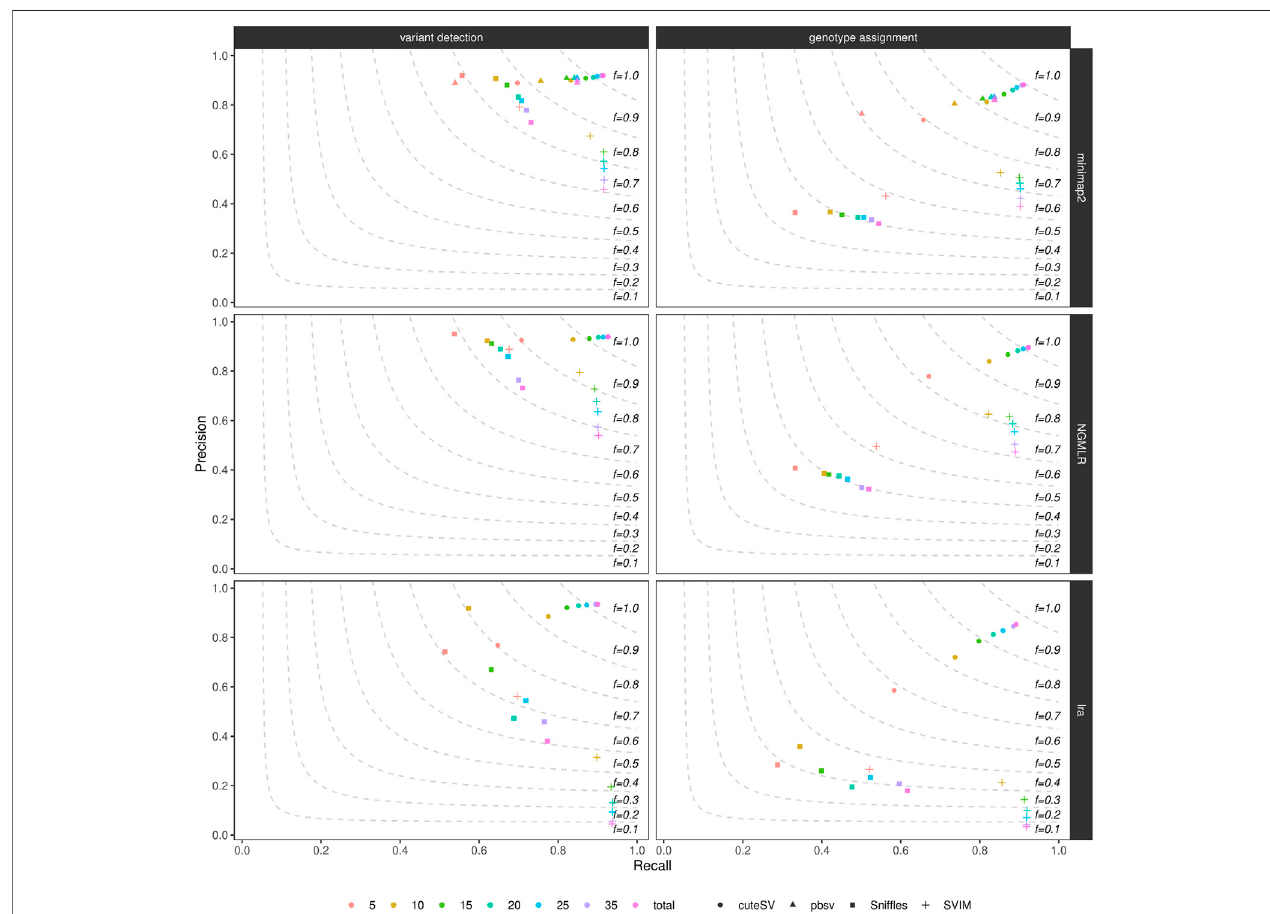
FIGURE 2 | Precision (y axis), recall (x axis) and F-score (dashed lines) of the SV callers Snif fl es (square symbol), SVIM (cross symbol), cuteSV (circle symbol) and pbsv(trianglesymbol)after minimap2(toppanels),NGMLR(midpanels)and lra(bottom panels)alignments.ResultsforbothSVcalling(left panels)andgenotyping(right panels)arereported.Theplotshowsthein fl uenceofaveragegenomecoverageafterdown-samplingNA24385alignmentstodifferentfractions(5X,10X,15X,20X,25X, 35X – hue palette) of the original coverage (total) on SV callers ’